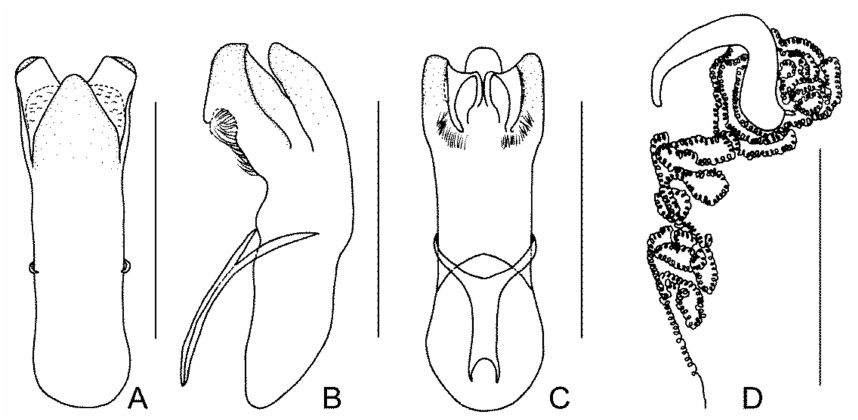
Figure 16. Cryptocephalus ( Burlinius ) exiguus amiculus Baly, 1873: ( A ) dorsal view of aedeagus; ( B ) lateral view of aedeagus; ( C ) ventral view of aedeagus; ( D ) spermatheca. (Scale bars: 0.5